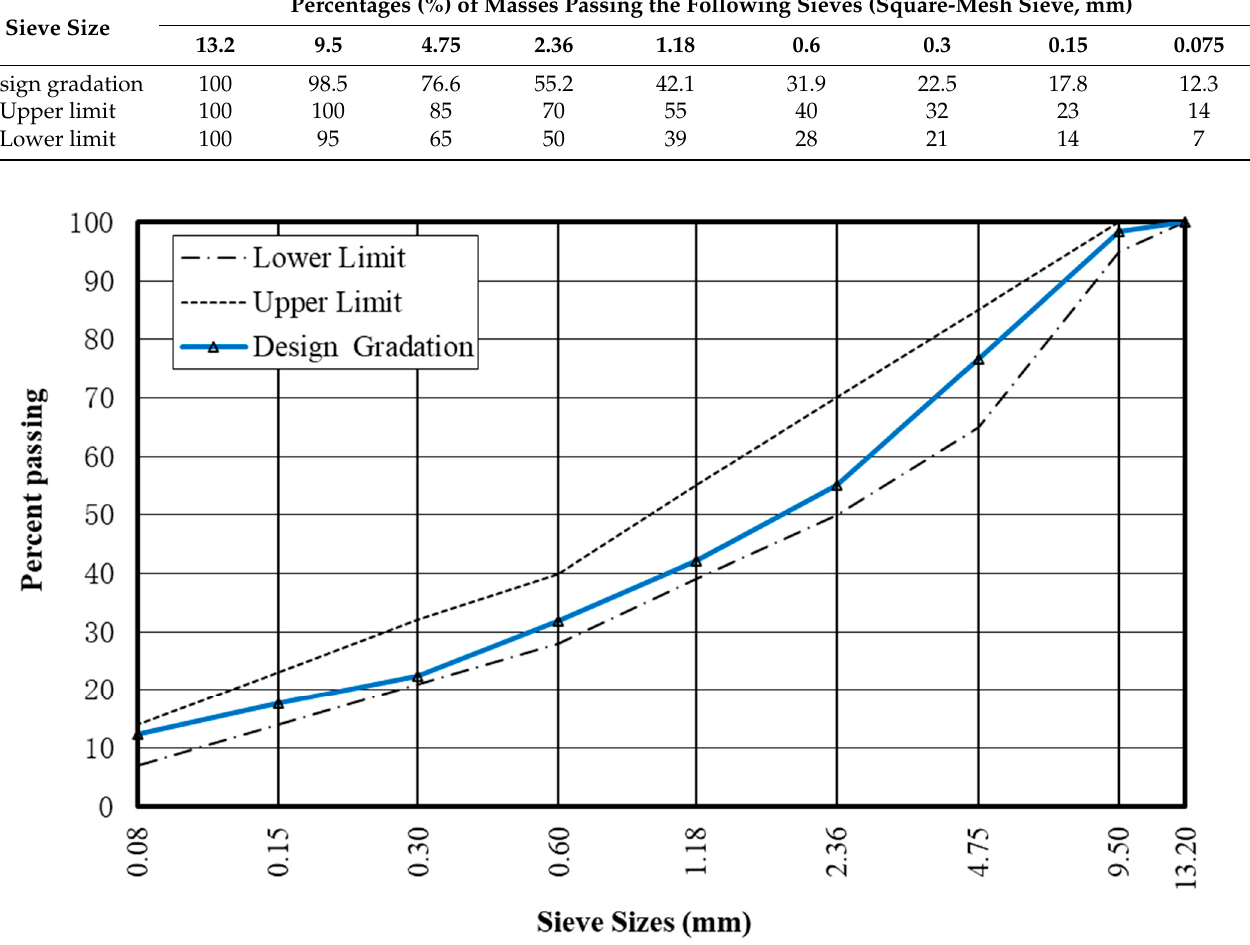
Figure 5. The gradation curve chart.